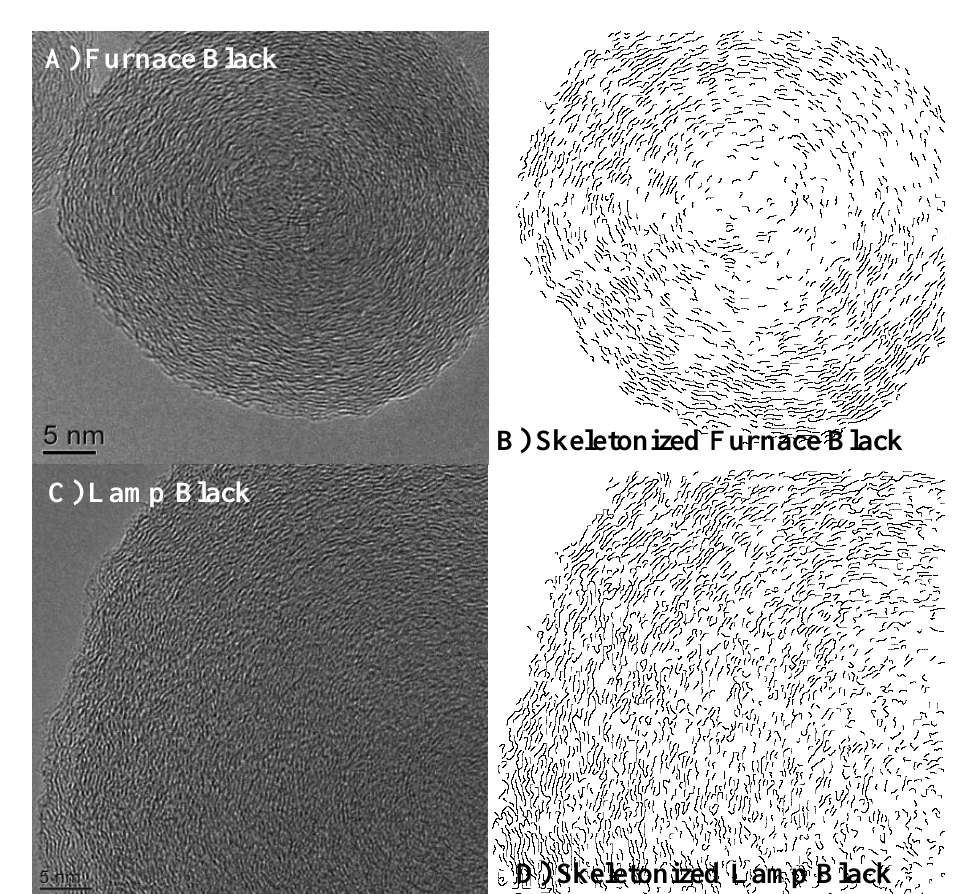
Figure 8. Image panel showing high-resolution TEM (HRTEM) and respective skeletonized images for ( A,B ) furnace and ( C,D ) lamp black.